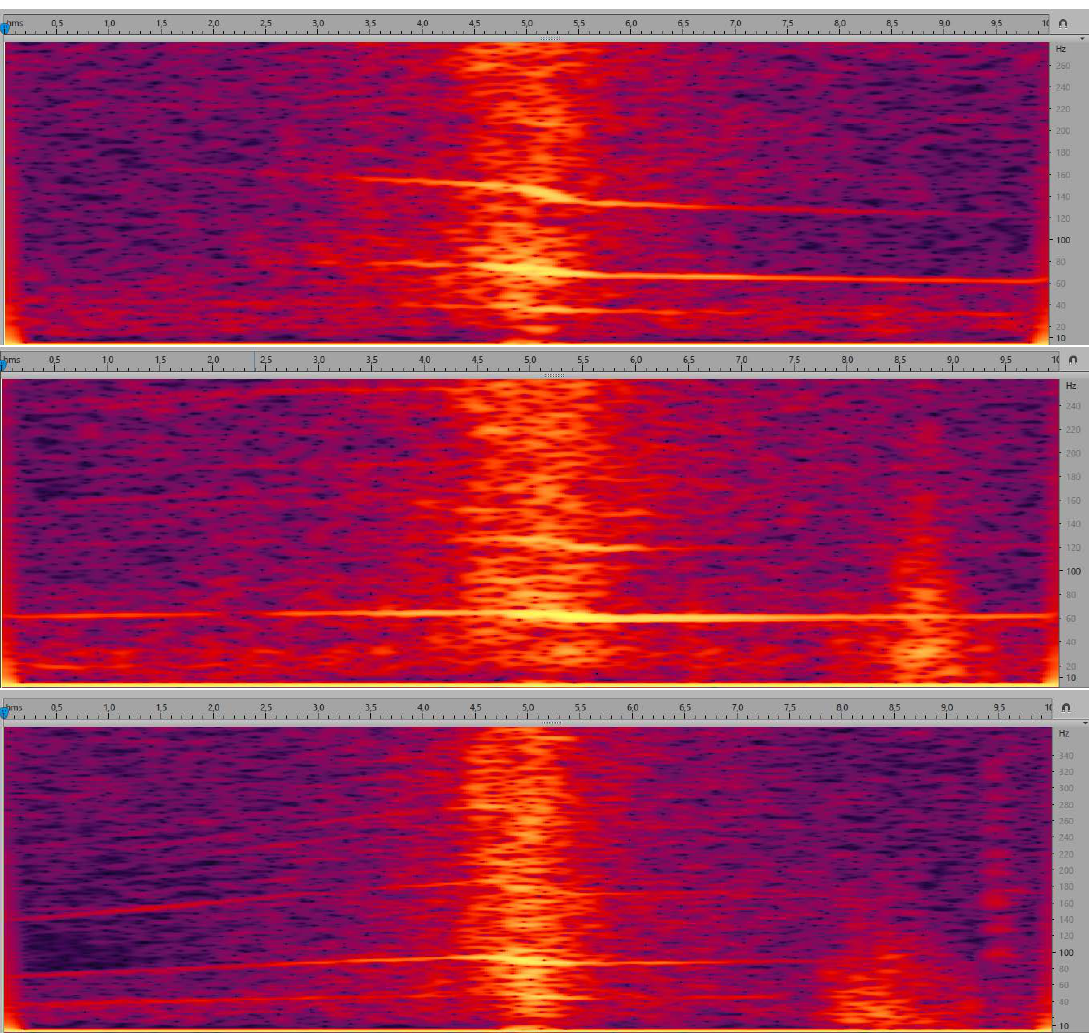
Figure 5. Spectrograms for deceleration ( upper graph ), stable speed ( middle graph ), and acceleration ( lower graph ). Horizontal axis represents time, vertical axis represents frequency. Higher luminance (brighter color) corresponds to higher amplitude. Graphs obtained from Adobe Audition